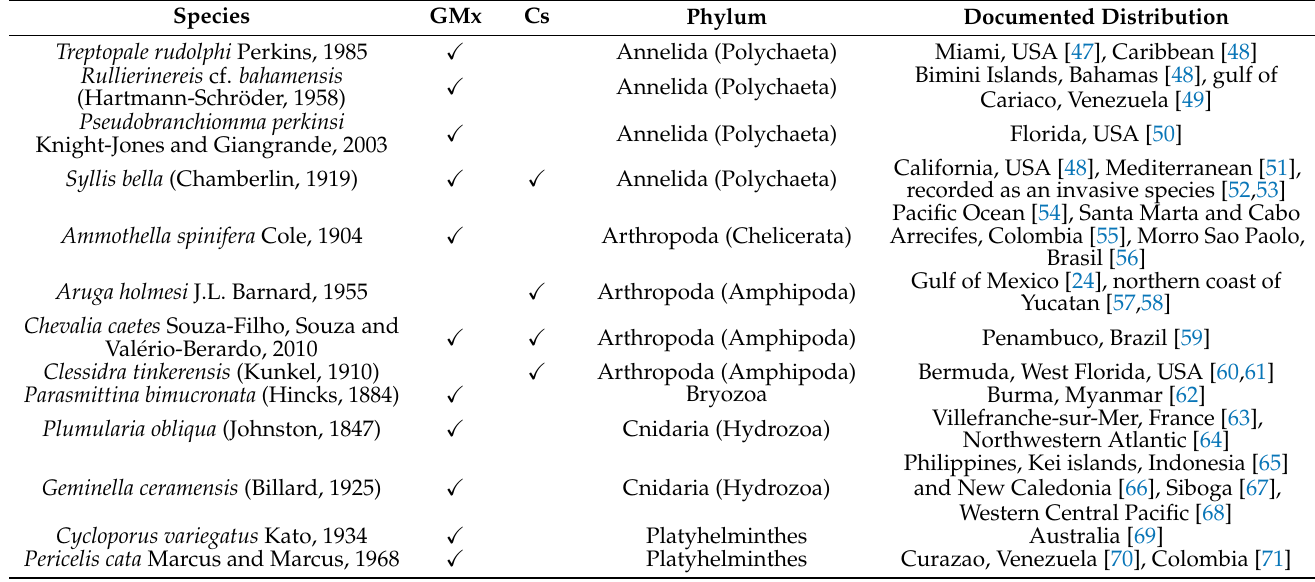
Figure 2. Number of species morphotypes (S) identified by phylum of the cryptofauna in autonomous reef monitoring structures (ARMS) during one year of recruitment in two reefs: Bajo de 10 reef (Campeche and Yucatan Bank Reefs, GMx = Gulf of Mexico) and Mahahual Reef (Mesoamerican Reef System, mC = Caribbean Sea). Table 1. New records per region of cryptic fauna species recorded in autonomous reef monitoring structures (ARMS) during a year of recruitment in Bajo de 10 reef and Mahahual Reef of the Yucatan Peninsula. GMx = Gulf of Mexico; mC = Caribbean